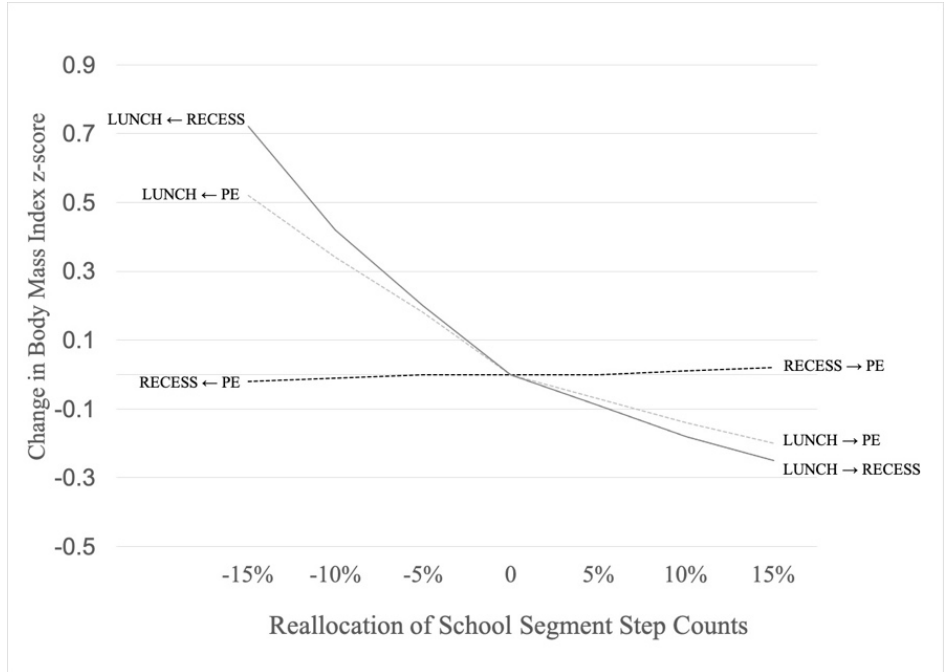
Figure 1. Change in body mass index z-scores per reallocation of step counts between school